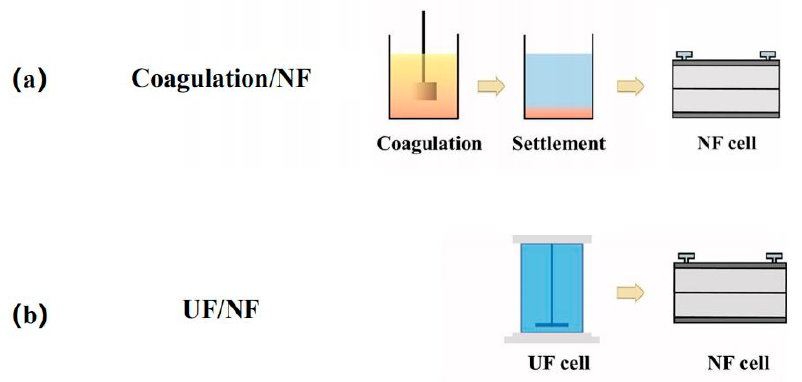
Figure 2. Schematic diagram of pretreatment process for NF: ( a ) coagulation/NF process; ( b ) UF/NF process. Reproduced with permission from Reference [86]. Copyright 2020, Elsevier.